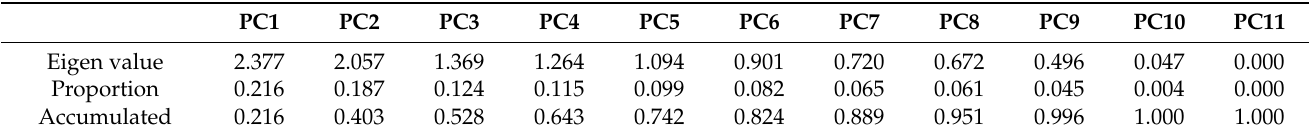
Table 2. Eigen values of the principal components.